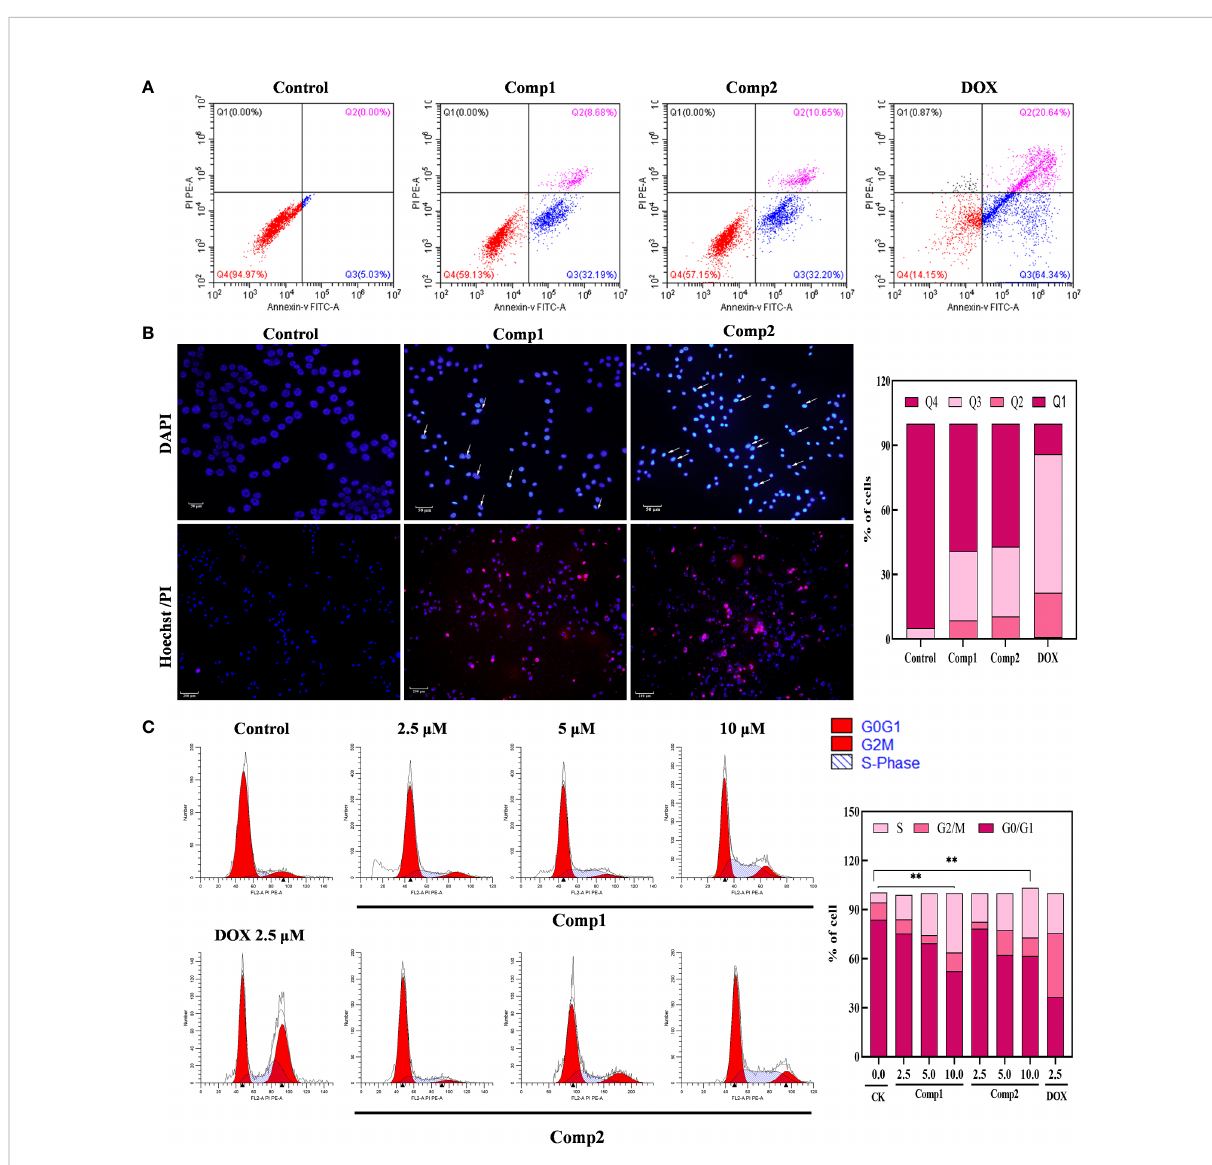
FIGURE 5 b -Carboline-3-carboxylic acid dimers promoted the apoptosis and induced arrest of cell cycle at S phase in MG-63 cells. (A) b - Carboline- 3-carboxylic acid dimers induce apoptosis in MG-63. MG-63 cells were treated with Comp1 and Comp2 (5 m M) for 48 h, and cells were then stained with Annexin V- fl uorescein isothiocyanate (FITC)/propidium iodide (PI) double labeling and subjected to fl ow cytometry. (B) Morphological observation was performed by Hoechst 33342/propidium iodide (PI) dual staining and DAPI staining. MG-63 cells seeded into 24-well plates were incubated with DMEM containing 5 µM of Comp1 and Comp2 for 48 h. (C) b - Carboline-3-carboxylic acid dimers induce cell cycle arrest. MG-63 cells were treated with Comp1 and Comp2 (2.5 m M, 5 m M, 10 m M) for 48 h, and the cell cycle distribution was analyzed by fl ow cytometry. The percentages of cells in the G1, S, and G2/M phases are presented statistically. **P < 0.01.